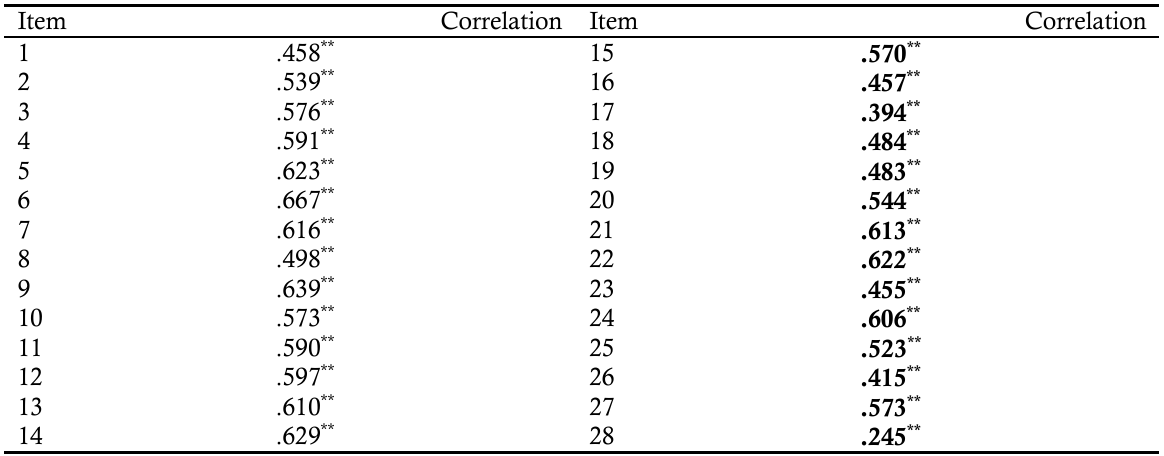
Table 1. Alexithymia Items’ correlations with the total